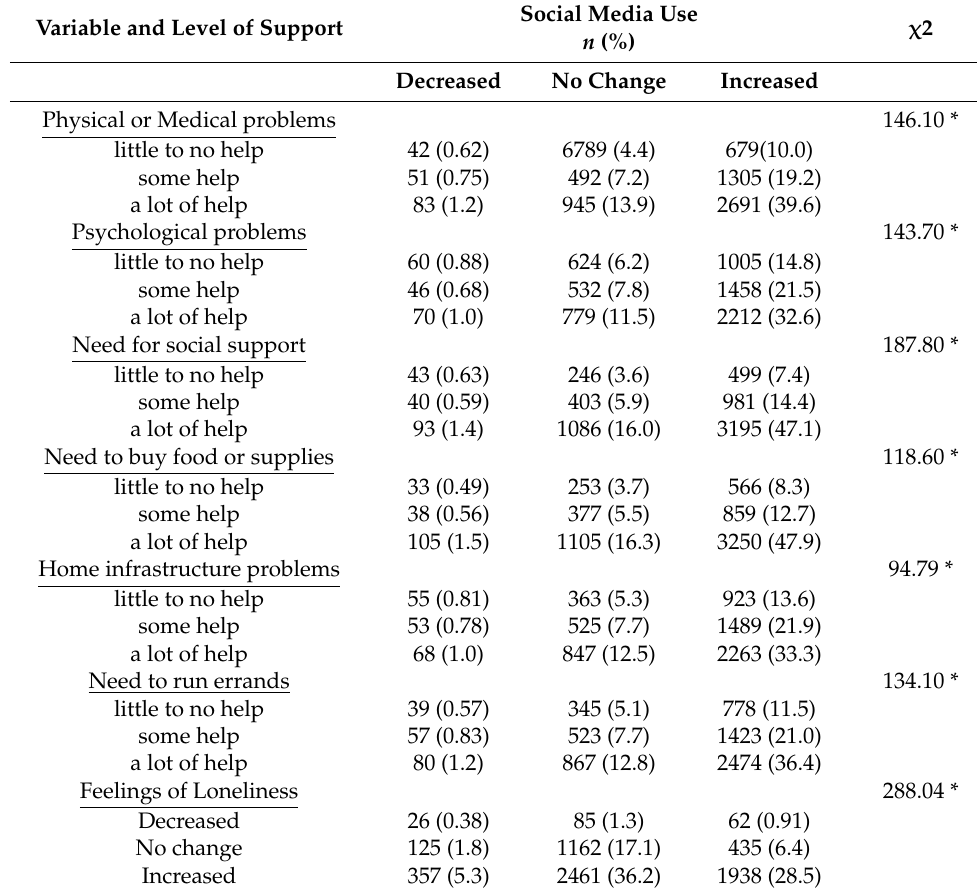
Table 6. Wave 1 perceived social support and loneliness by social media use and Chi-square associa- tions during confinement in April 2020 ( n =